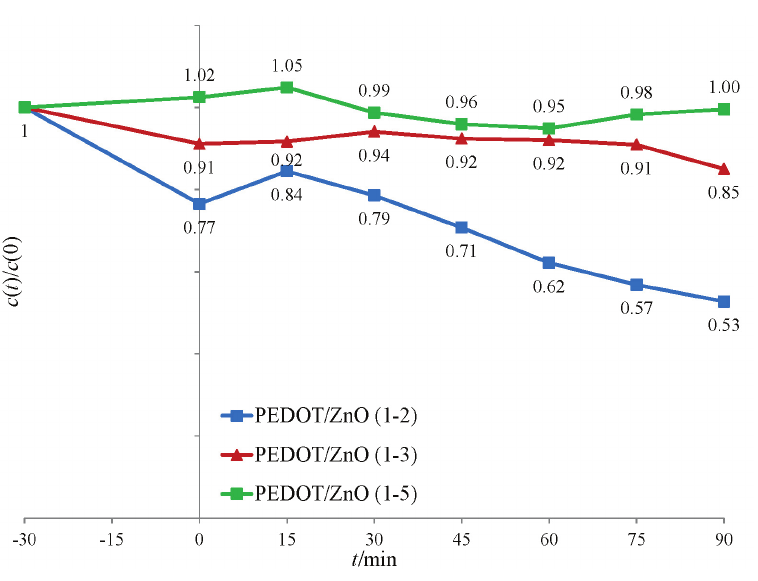
Fig. 10 – Rate of discoloration of RR45 dyes during photocatalysis under simu- lated solar irradiation by using synthesized composite PEDOT/ZnO nanocomposite photocatalysts ( g